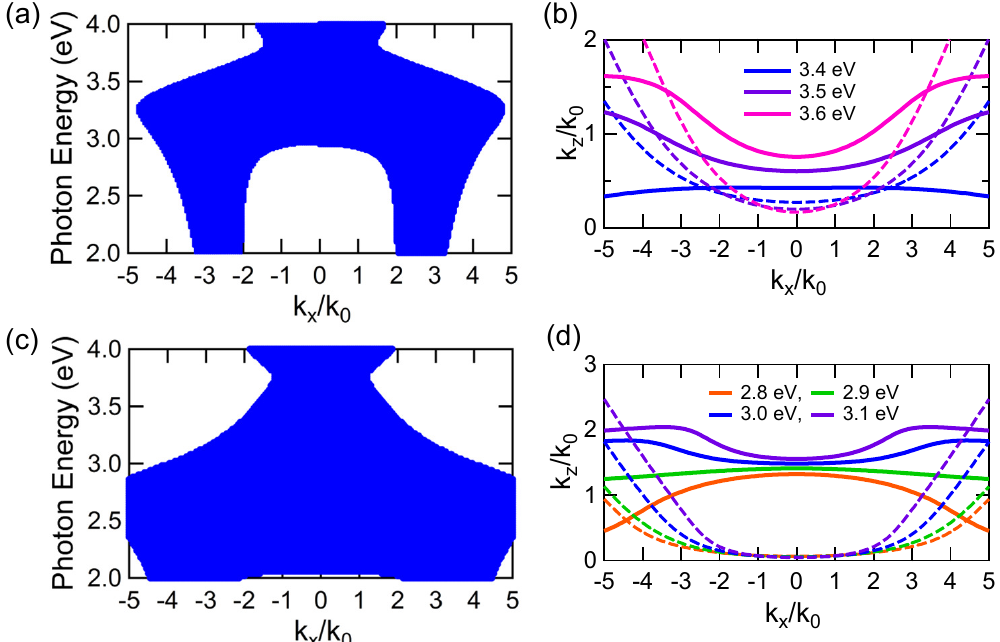
Figure 7. Other SMIMs reported to date. ( a ) TM-polarized transmission Bloch band of a SMIM of the (Ag 30 nm / SiO 30 nm) unit cell (blue). The band was extracted under the 2 relatively large-loss condition. ( b ) Equi-frequency contours at 3.4 (blue), 3.5 (purple) and 3.6 eV (light purple) in (a), which appear from the bottom to the top. Solid lines denote the real part and dashed lines the imaginary part. ( c ) TM-polarized transmission Bloch band of SMIM of the (Ag 30 nm / insulator (I) 50 nm) unit cell, where I has a permittivity of 4.84. The band was extracted similarly to (a). ( d ) Equi-frequency contours at 2.8 (orange), 2.9 (green), 3.0 (blue) and 3.1 eV (purple) in (c), which appear from the bottom to the top. The real and imaginary parts are shown in a similar way to